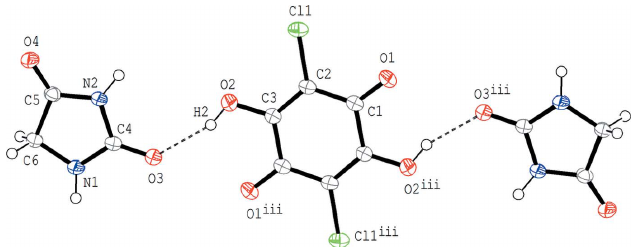
Figure 2 The molecular structure of compound (II), showing the atom-numbering scheme. Displacement ellipsoids of non-H atoms are drawn at the 50% probability level and H atoms are drawn as small spheres of arbitrary radii. O—H (cid:2)(cid:2)(cid:2) O hydrogen bonds are shown by dashed lines. [Symmetry code: (iii) (cid:4) x + 1 , (cid:4) y + 5 , (cid:4) z + 1.] 2 2